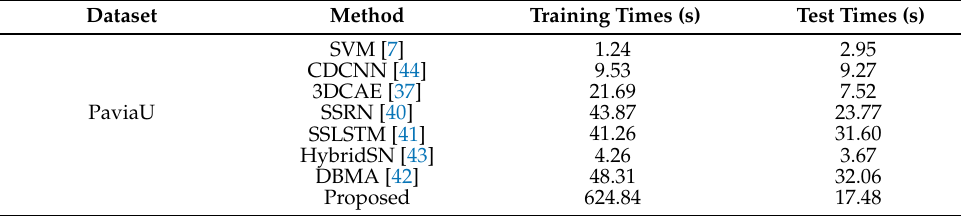
Table 12. Training and testing time on the University of Pavia dataset.